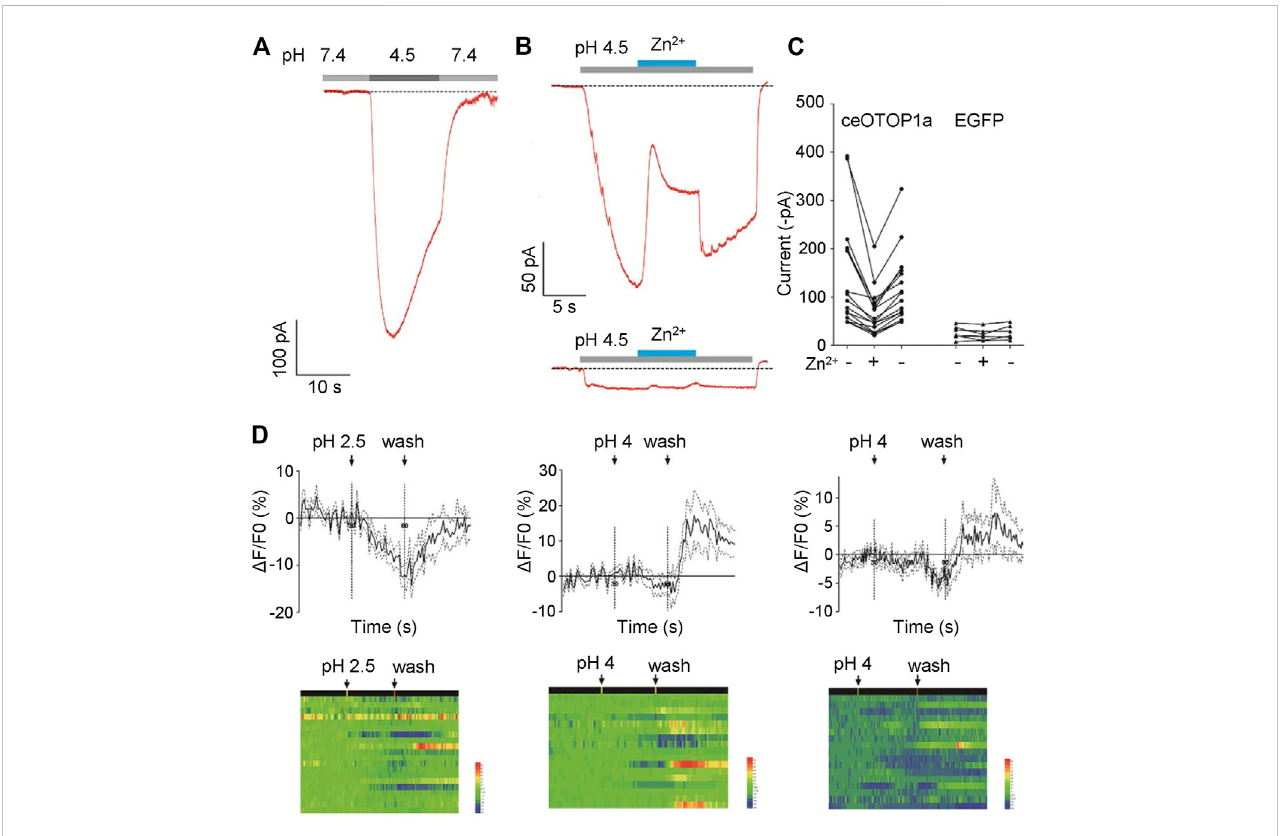
FIGURE 2 CeOTOP1a heterologous expression in HEK273T cells shows zinc ion-sensitive acid-responsive currents. (A) Acid-evoked currents were recorded by whole-cell patch clamp recording in HEK273T cells heterologously expressing nematode ceOTOP1a. The membrane potential was clamped at − 80 mV. (B) Acid-evoked currents can be reversible by 1 mM Zn 2+ . The gravity perfusion system was used, switching channels to replace the solution. Membrane potential was clamped at − 80 mV. Acid stimulation (grey), Zn 2+ application (blue). (C) Statistics of the current amplitude. Membrane potential was clamped at − 80 mV. (D) Acid stimulation does not induce signi fi cant calcium responses in ASI